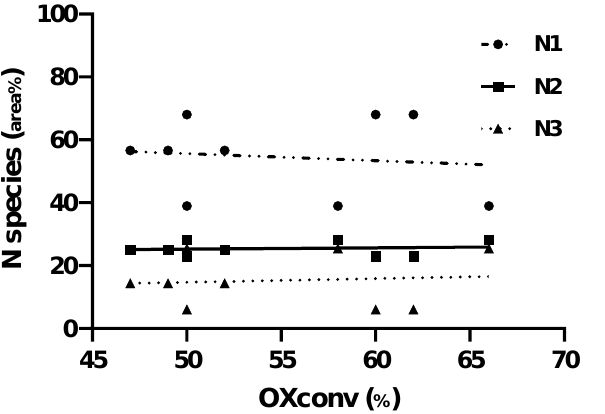
Figure 10. Correlation attempts between oxalic acid conversion as a function of N-species measured by XPS.